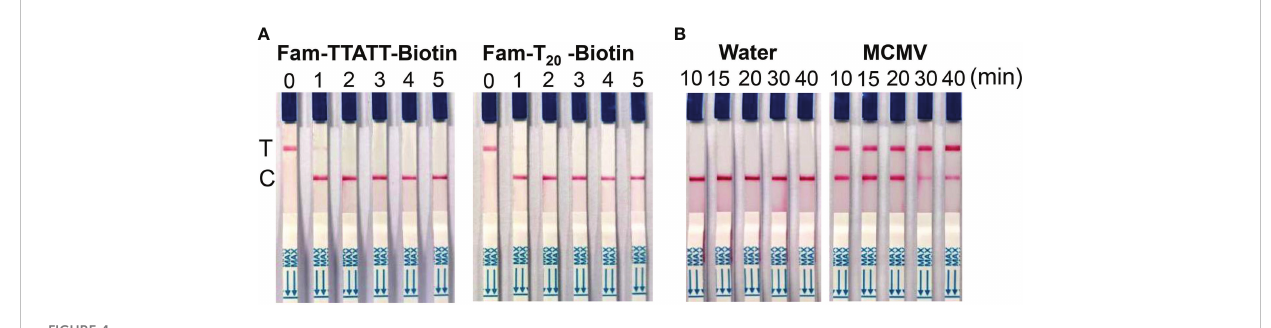
concentration (96.0 ng) and the lowest RNA concentration (9.6 × 10 -5 ng) were excluded out of the linear range, and the concentration range from 9.6 ng to 9.6 × 10 -4 ng was linearly fi tted with a R 2 value of 0.963 (Figure 6B).